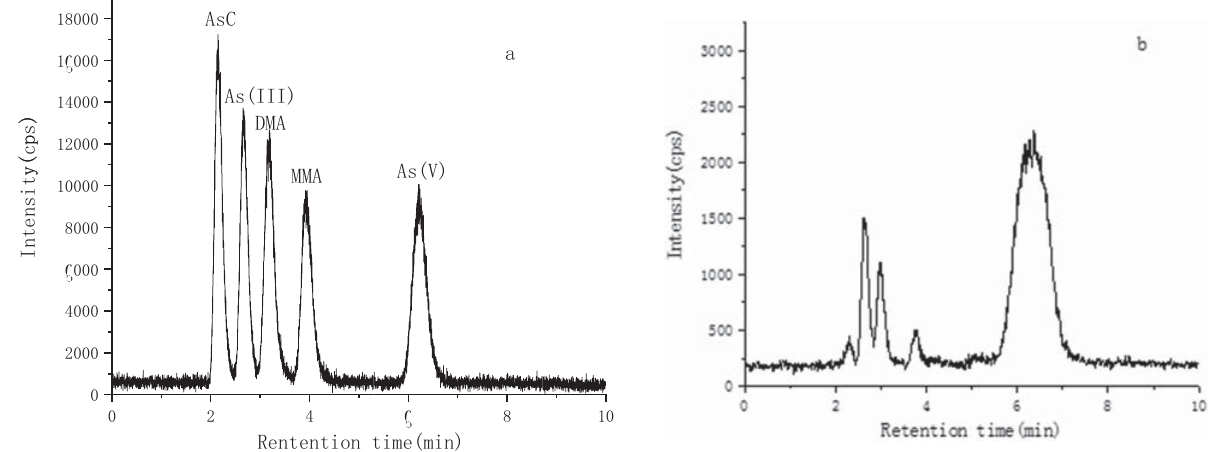
Figure 1: Spectrogram of As speciation AsC, As ( III ) , DMA, MMA, As ( V ) : ( a ) 10 μ g/L mixed standard solution of As speciation; and ( b ) spectrogram of honeysuckle fl ower in Fengqiu area.